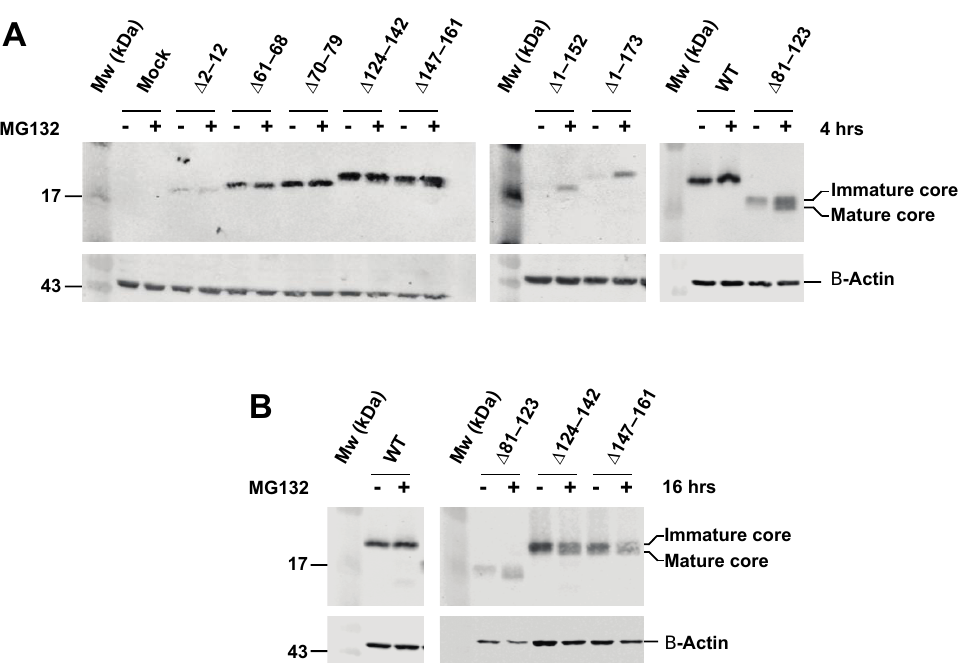
Figure 2. Expression and stability of HCV C mutant proteins. ( A ) HeLa T-REx cells transfected with plasmid encoding either full length (wt) or mutant C proteins. After 48 h, cells were lysed and presence of C was detected by Western blotting. In panel A, (+) indicates lanes; cells were treated with 10 µ M MG 132 for 4 h before harvesting. ( B ) HeLa T-REx cells transfected with plasmid encoding C mutants ∆ 81–123, ∆ 124–142 and ∆ 147–161 were treated with 10 µ M MG132 for 16 h. Actin was used as loading control. The positions of molecular weight markers (kDa) are indicated to the